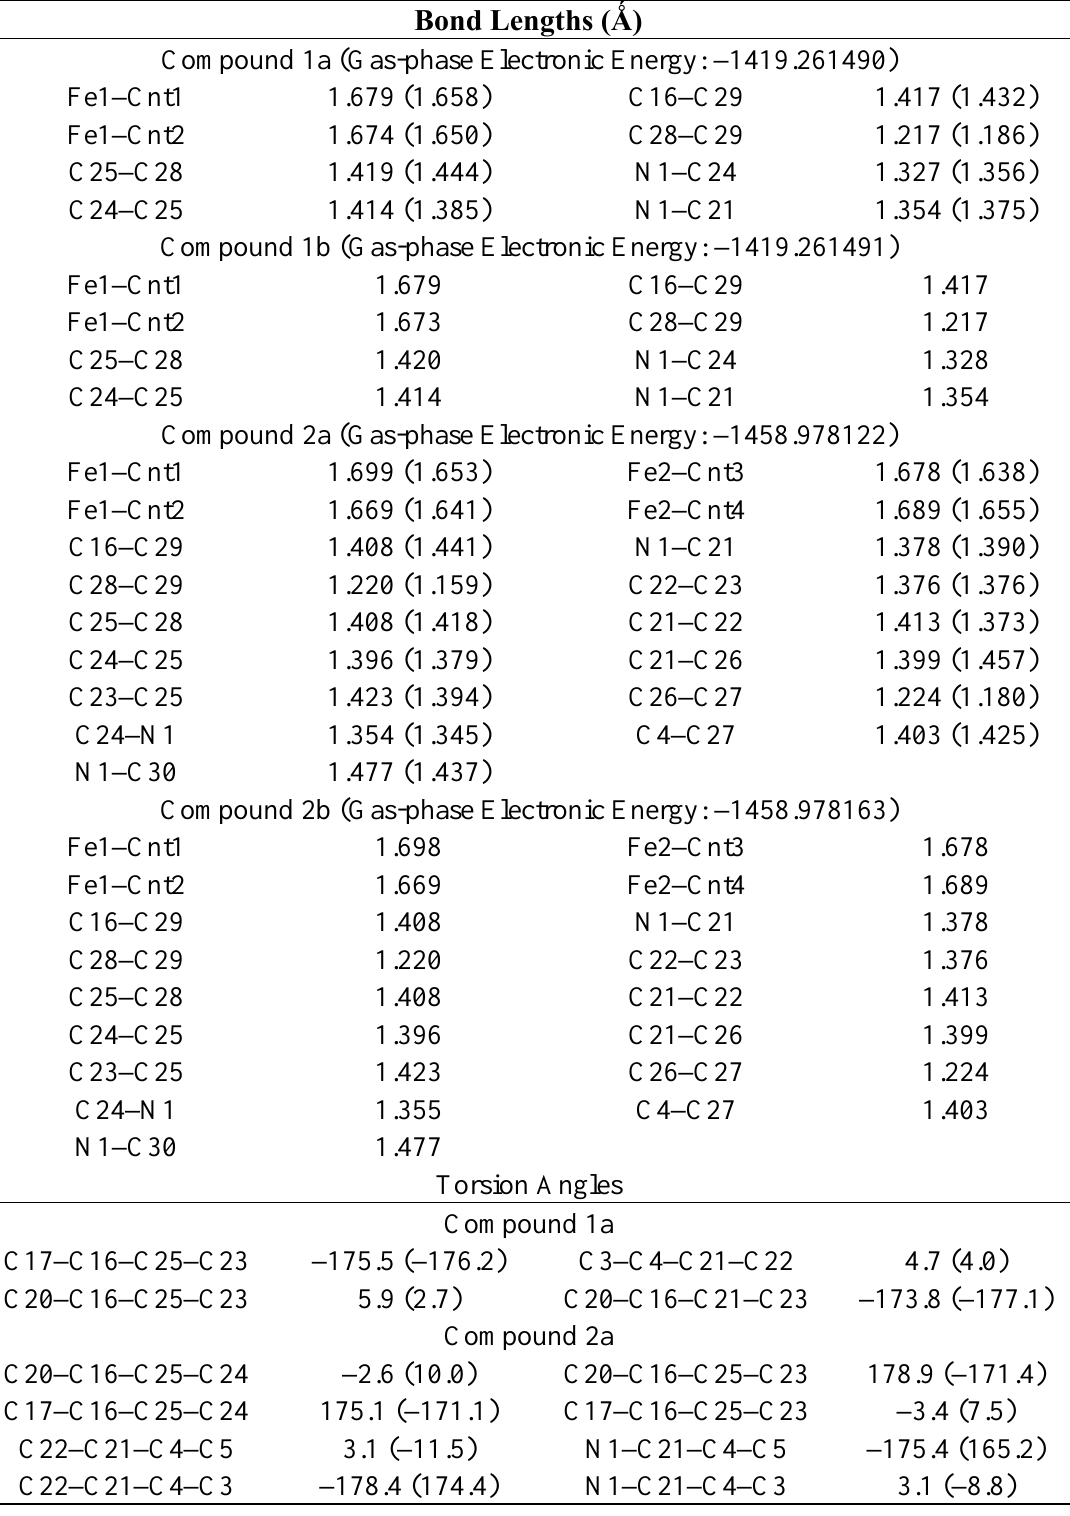
Table 1. Selected theoretical bond lengths (Å) and torsion angles (Deg) for compounds 1 and 2. The experimental X-ray crystallographic data are listed in